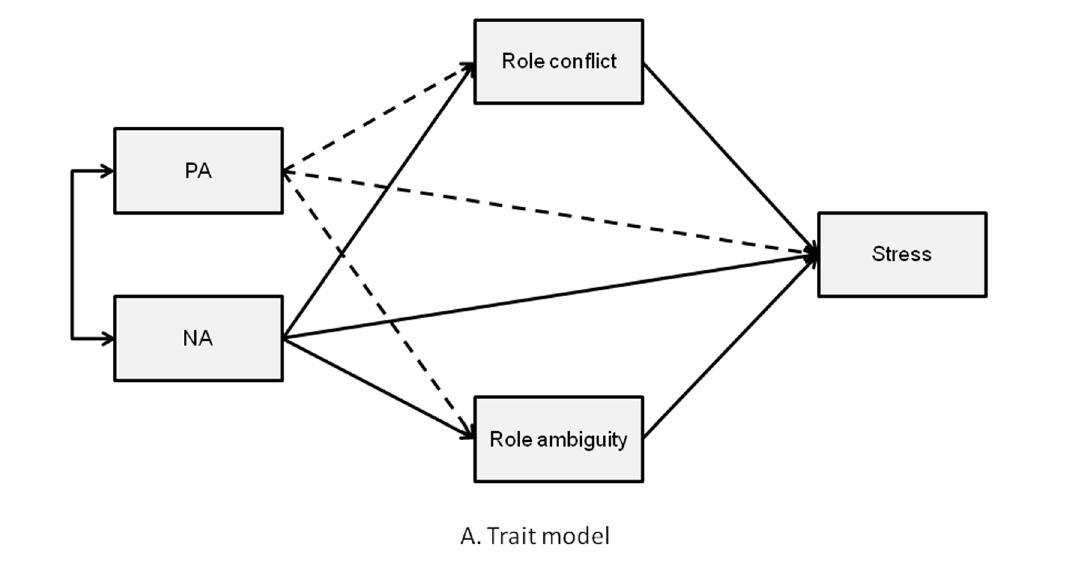
Figure 1.A. Trait model: NA as causal agents to perceived work-related stressors and strain outcomes (the dashed lines indicates that no impact from PA should be expected).